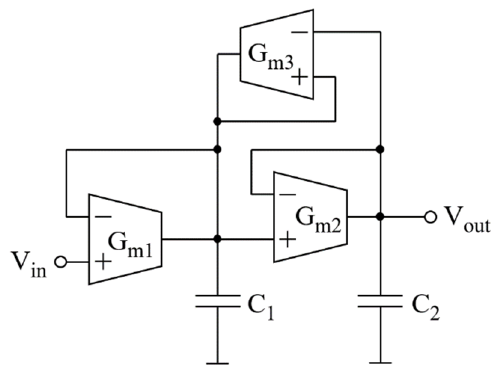
Figure 7. Structure of a second-order low-pass filter frequently used in electronic cochlea implementations.